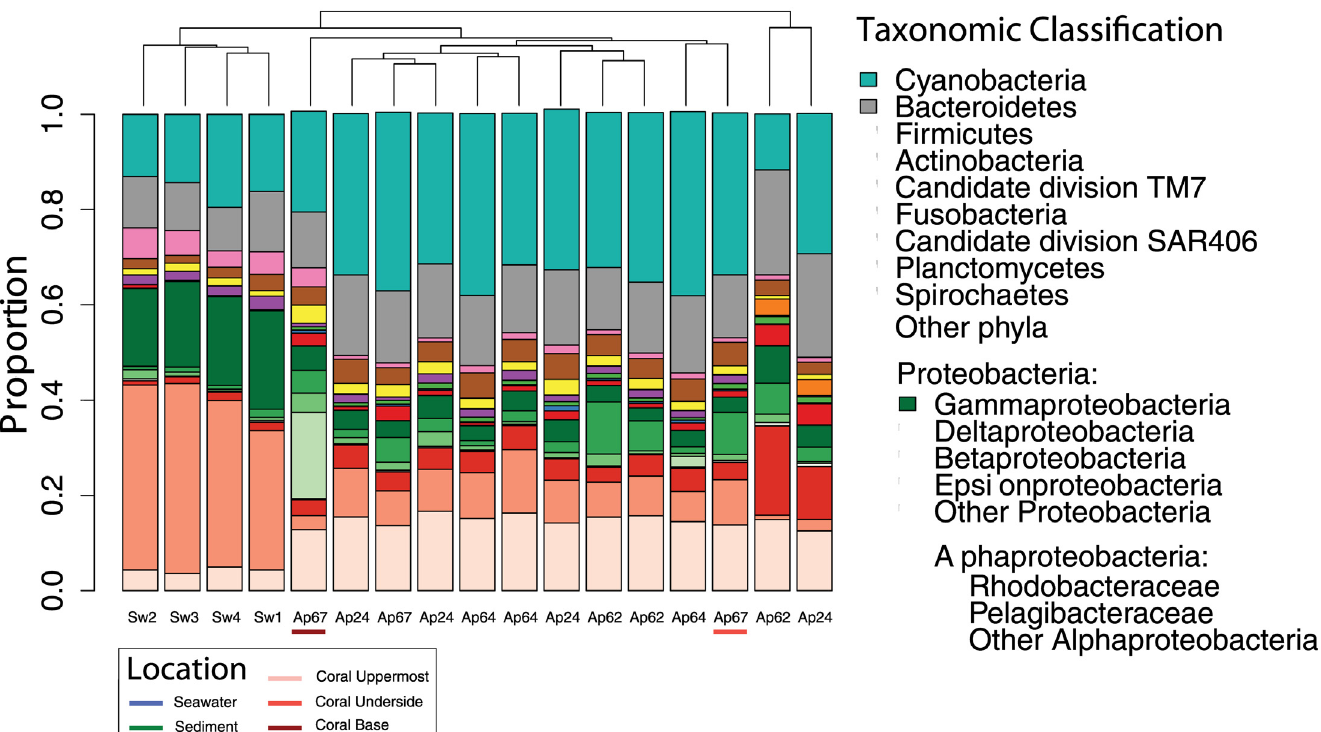
Fig 3. Microbial diversity in different regions of the SML of A . palmata (n = 3 – 4; 11 samples), reef seawater (n = 4), and adjacent sediment (n =